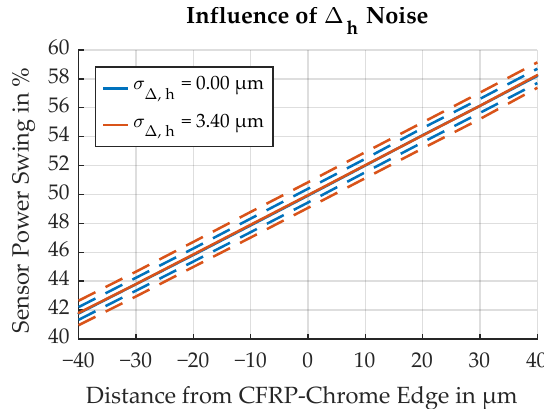
Figure 24. Demonstration of the effect of different values of ∆ h . The influence of ∆ h is comparatively large and has to be corrected.